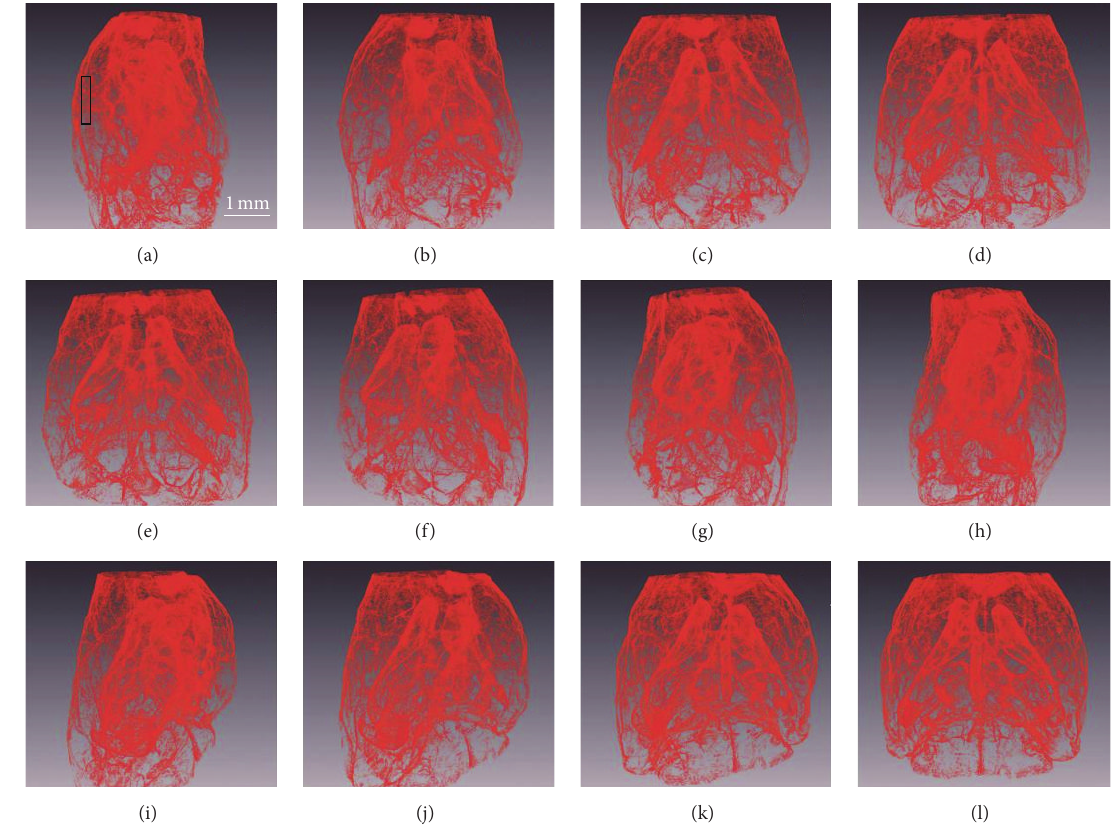
Figure 4: 3D reconstruction of entire mouse brain vasculature. The rendered vasculature is rotated by 15 ∘ in each image ((a) to (l)). The scale bar is 1mm.